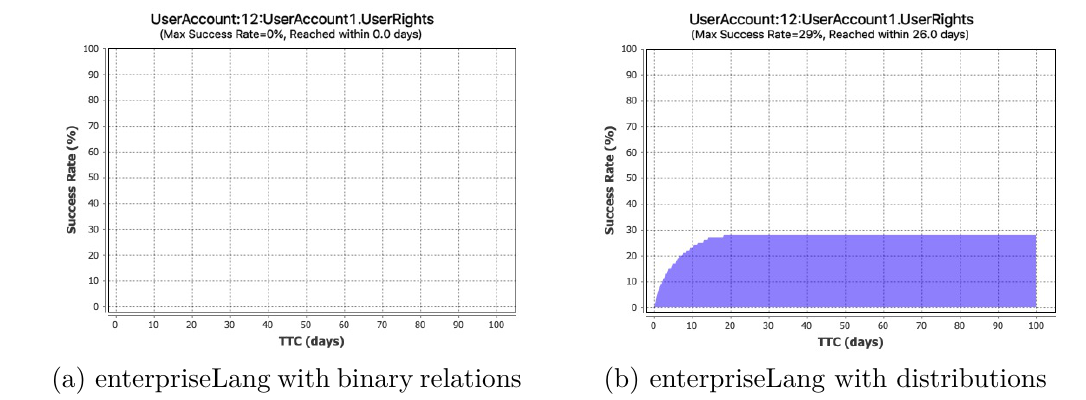
Figure 12. Simulation results comparison of the global TTC to compromise a certain attack